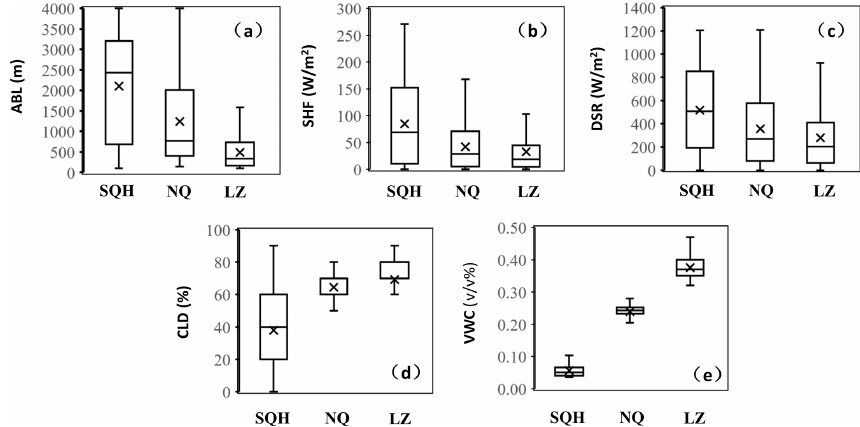
Figure 10. (a) The ABLH, (b) SHF, (c) DSR, (d) CLD, and (e) VWC at SQH, NQ, and LZ stations in the study period. Horizontal bars show the 5th, 25th, 50th, 75th, and 95th percentile values, and “ × ” symbols show the corresponding mean value.